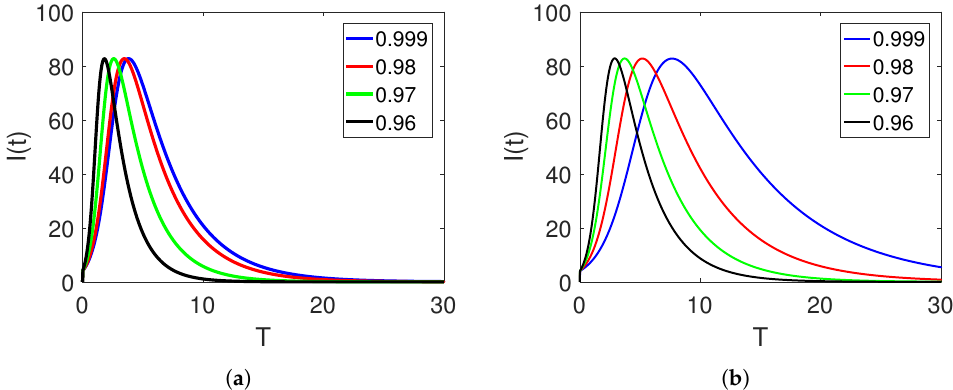
Figure 15. Comparison of Newton polynomial ( a ) and LADM ( b ) for third class on different arbitrary fractional